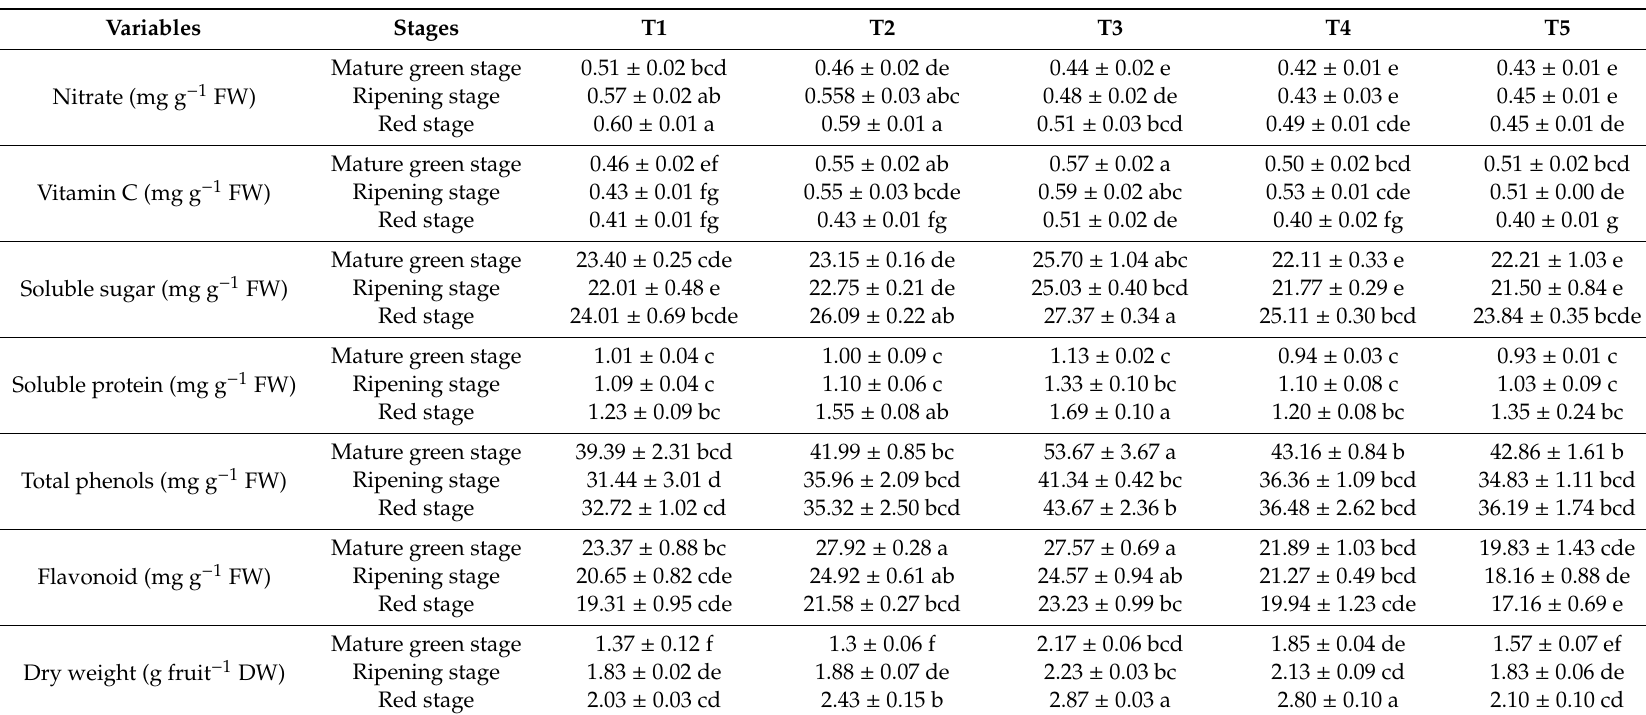
Table 6. E ff ects of NH 4 + :NO 3 − ratios on quality of pepper fruit at the three stages in response to di ff erent NH 4 + :NO 3 − ratios.